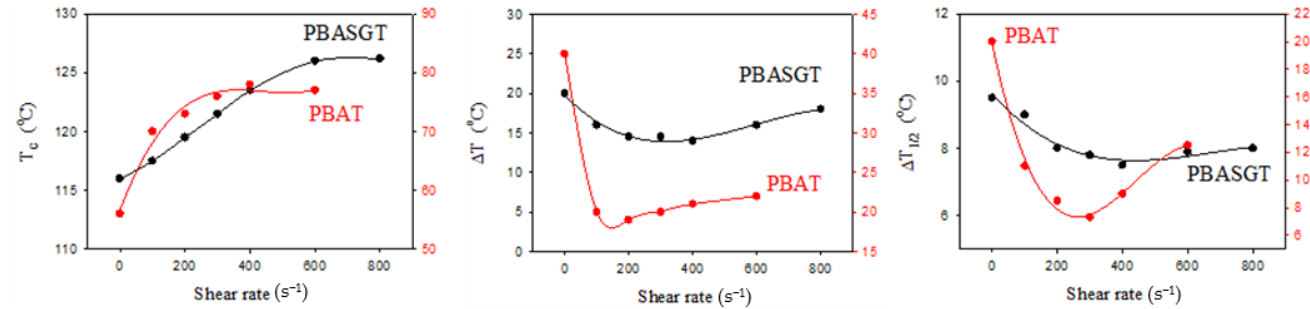
Figure 4. Shear rate dependences of T c , Δ T and Δ T 1/2 of PBAT and PBASGT, crystallized from the melt. The samples were cooled down with simultaneous shearing at various shearing rates.